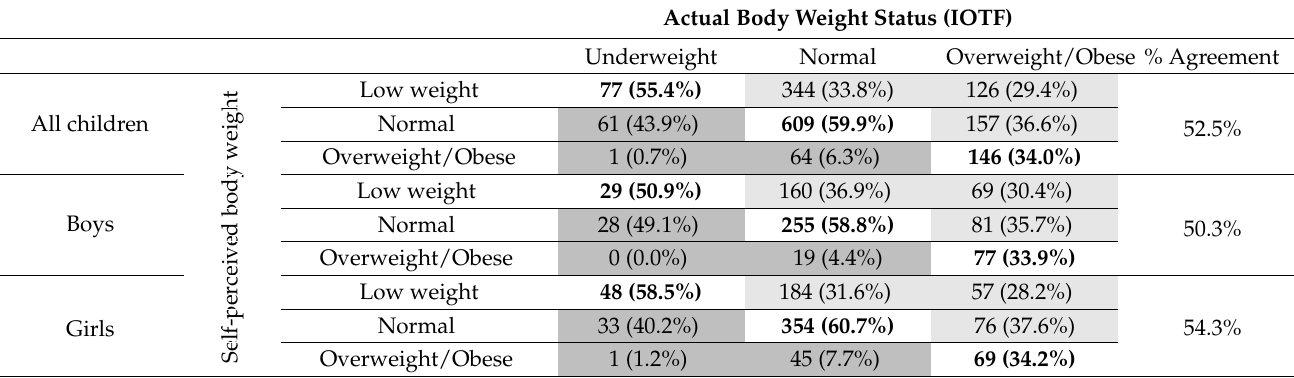
IOTF = International obesity task force; BMI = Body mass index. The rates of children’s self-perceptions about their body weight which was in accordance with their actual BMI status are presented in bold. The rates for children’s underestimation are presented in the light grey colored cells. The rates for children’s overestimation are presented in the deep grey colored